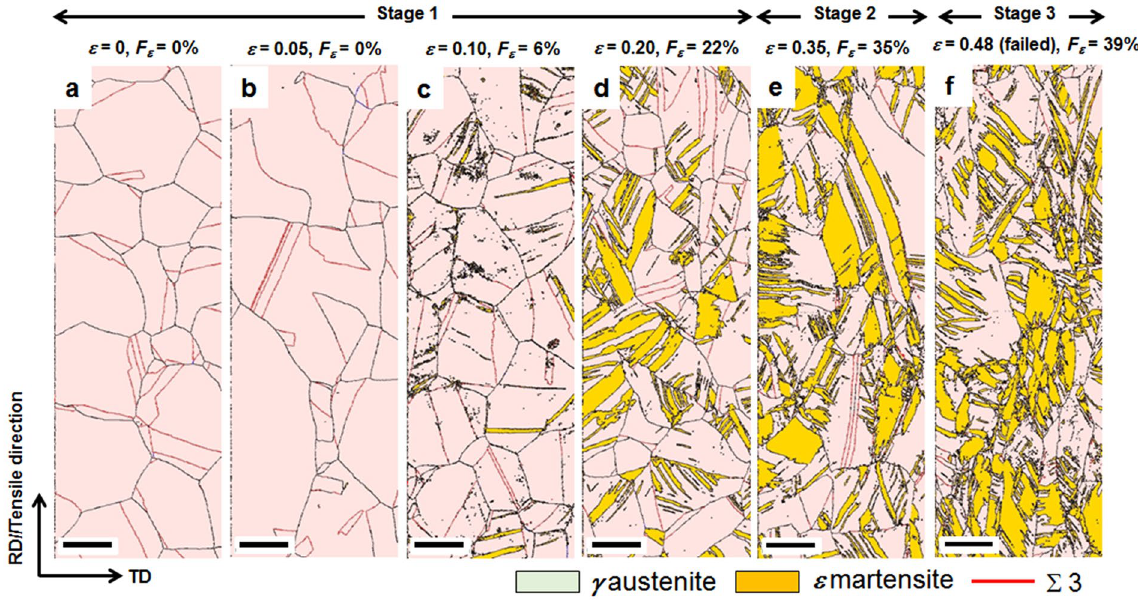
Figure 2. EBSD phase maps showing microstructural evolution with true strain in 0C steel. The strains are ( a ) 0, ( b ) 0.05, ( c ) 0.10, ( d ) 0.20, ( e ) 0.35 and ( f ) 0.48 (failed specimen). RD and TD: rolling and transverse directions, respectively. F ε : the fraction of ε martensite. Scale bar, 10 μ